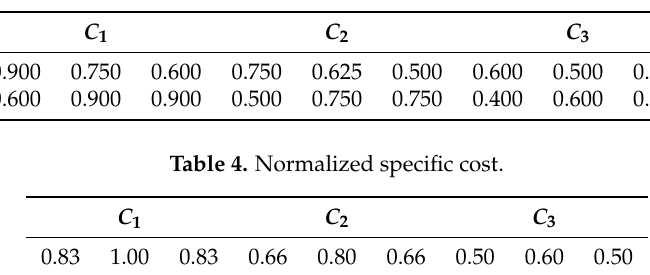
Table 3. Prior probabilities of immigration.